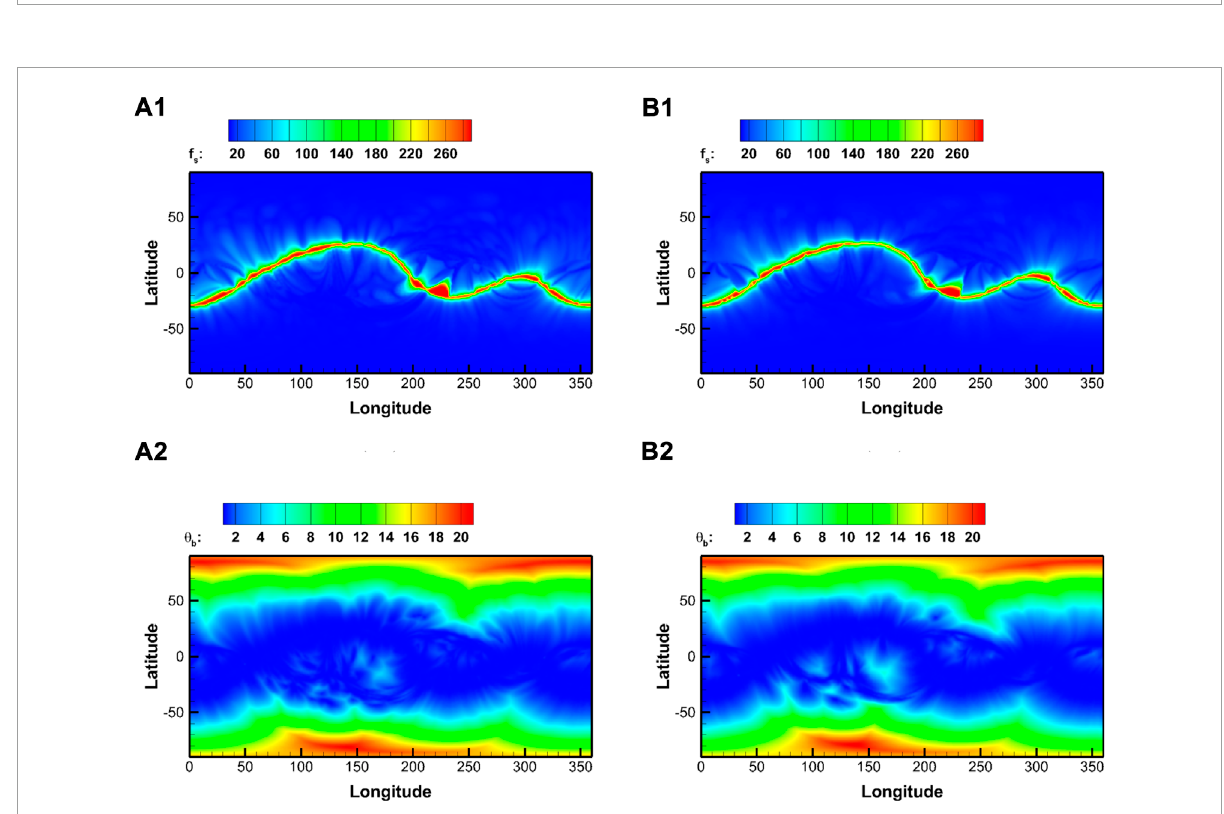
numericalsolversin Figure 5 .Theblack,greenandmagentalines represent the radial fields obtained by the SHE, FDIPS and DDG- PFSS solvers, respectively. The backgrounds are colored with